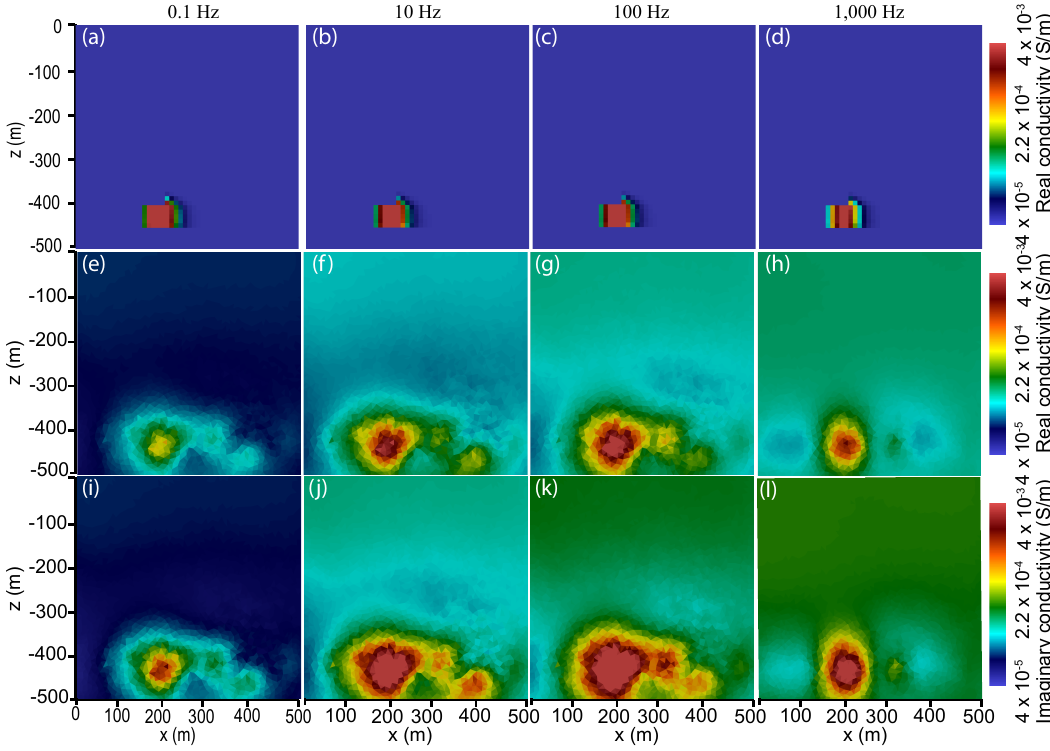
Figure 6. Simulated and estimated frequency-dependent electrical conductivities at y = 250m after one year. ( a – d ) True-electrical conductivities from the PFLOTRAN-SIP framework, ( e – h ) estimated bulk-real conductivities from SIP inversion, and ( i – l ) imaginary components of estimated bulk complex electrical conductivities from SIP